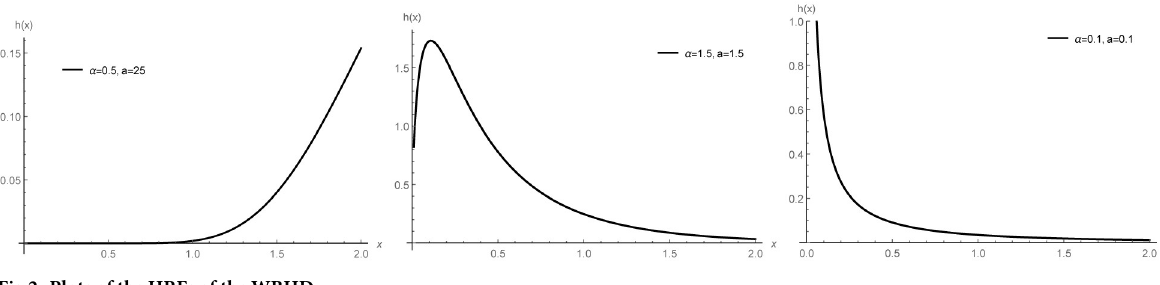
Fig 2. Plots of the HRFs of the